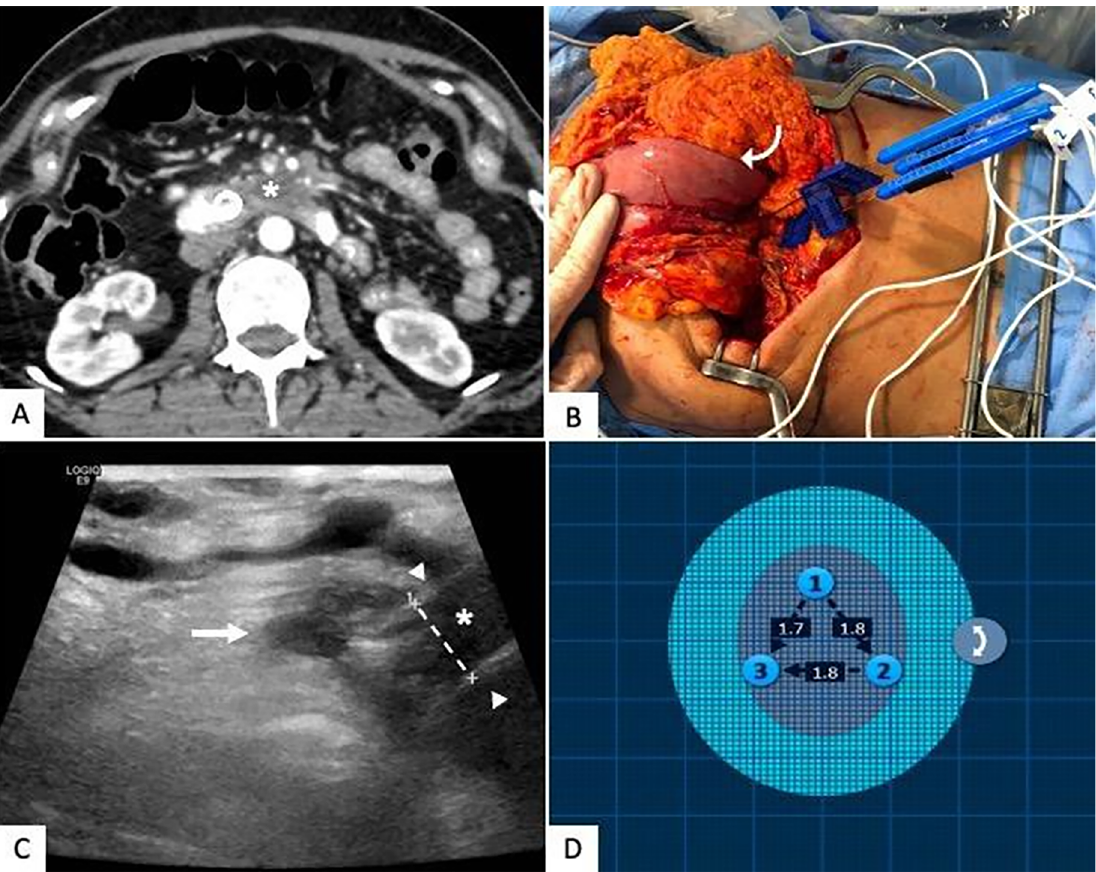
Figure 1. Surgical IRE for a borderline pancreatic neoplasm. A. Pancreatic neoplasm located in the uncinated process and in contact with mesenteric vessels (arrow); B. Surgical dissection of the pancreas with midline incision allowing probe positioning; C. Insertion of the probes were guided by ultrasound to avoid mesenteric artery (arrow) injury and to measure the inter-electrode distance (dashed line); D. Diagram of the final probe positioning with the inter-electrode